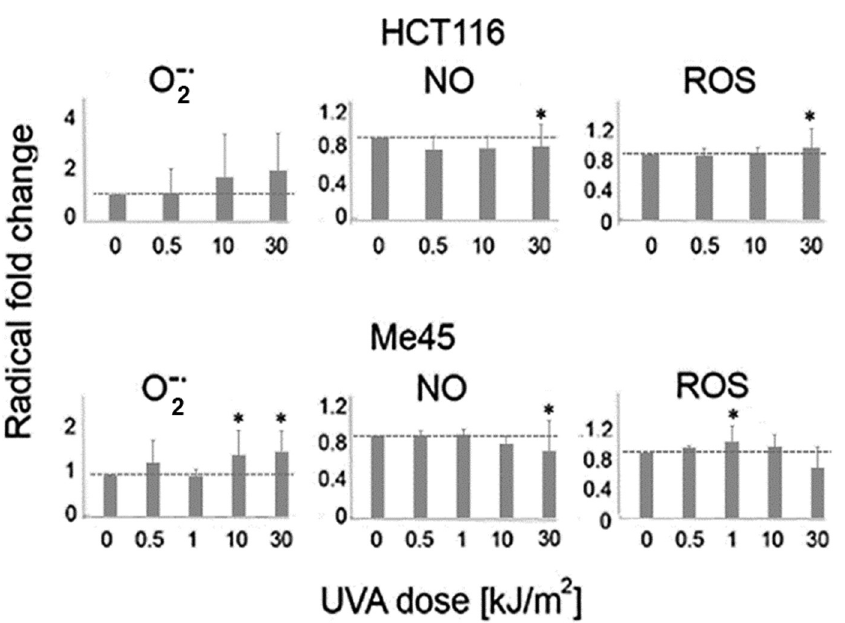
Fig 2. Average levels of ROS and NO in HCT116 and Me45 do not significantly change after exposure of cells to different UVA doses. The levels were measured four times during 24 h in control and cells irradiated with different UVA doses and experiment was repeated 4 times. The results are presented as fold change in irradiated cells versus non-irradiated controls. Data show the mean and standard deviation from 4 experiments; statistically significant differences (p < 0.05) were marked with an